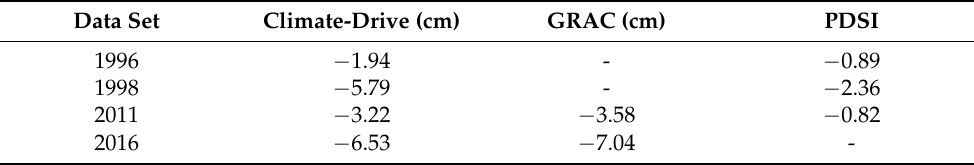
Figure 8. Yearly drought patterns as interpreted from the Palmer Drought Severity Index (PDSI). Note that the yearly drought patterns are the mean nonseasonal TWSC or PDSI from July of the previous year to June of the current year (e.g., the 1993 drought patterns are the mean during July 1992 through June 1993). Table 3. Average climate-driven TWSC, GRACE TWSC, and PDSI over the Amazon basin in the four drought years (i.e., 1996, 1998, 2011, and